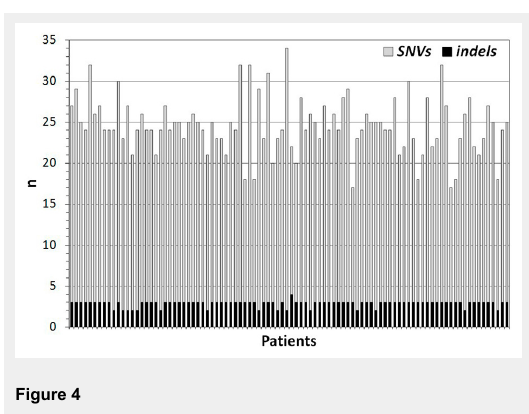
Figure 4 Number of SNVs and indels identified in each of the 94 patients for APOB , LDLR , and PCSK9 . Each bar corresponds to a single sample. SNV = single nucleotide variant; indel = short insertion and/or